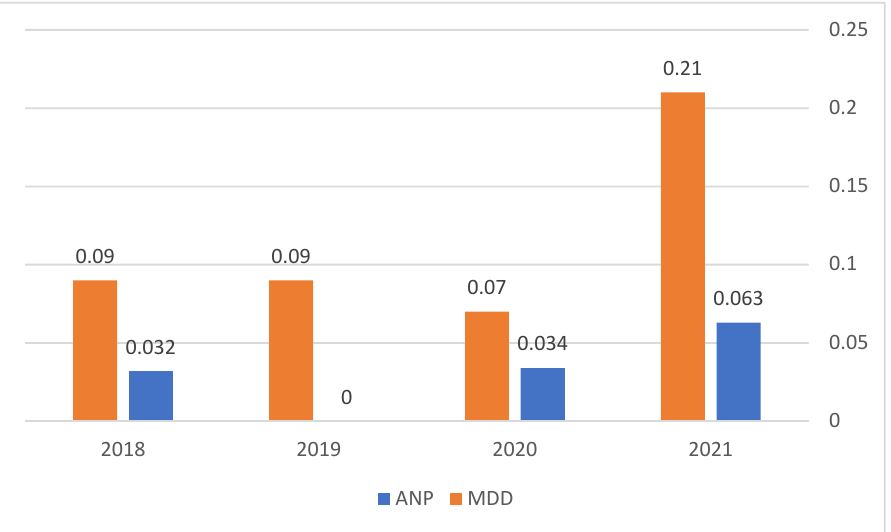
Figure 5. XRP average NP and MDD per trade for 2018–2021. Note: ANP = average trade net profit, MDD = maximum loss per trade. The data for 2021 is until the end of September 2021.